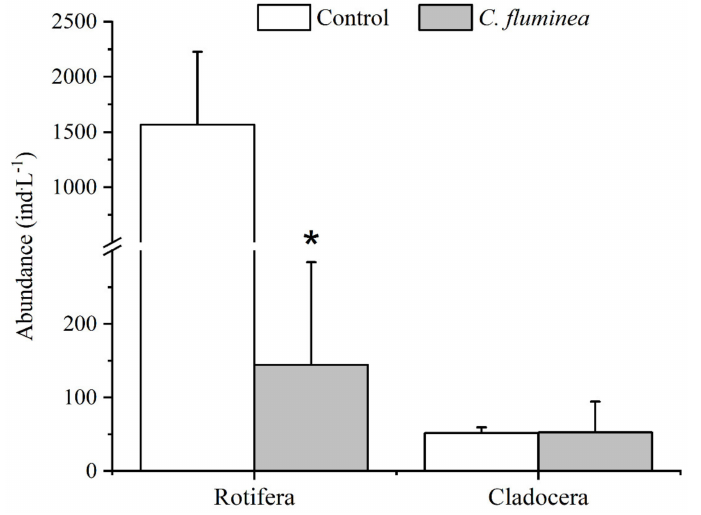
Figure 7. Abundance of zooplankton in different treatments (mean ± SD) at the end of the experiment. Asterisk indicates significant differences between the treatments and controls ( p <